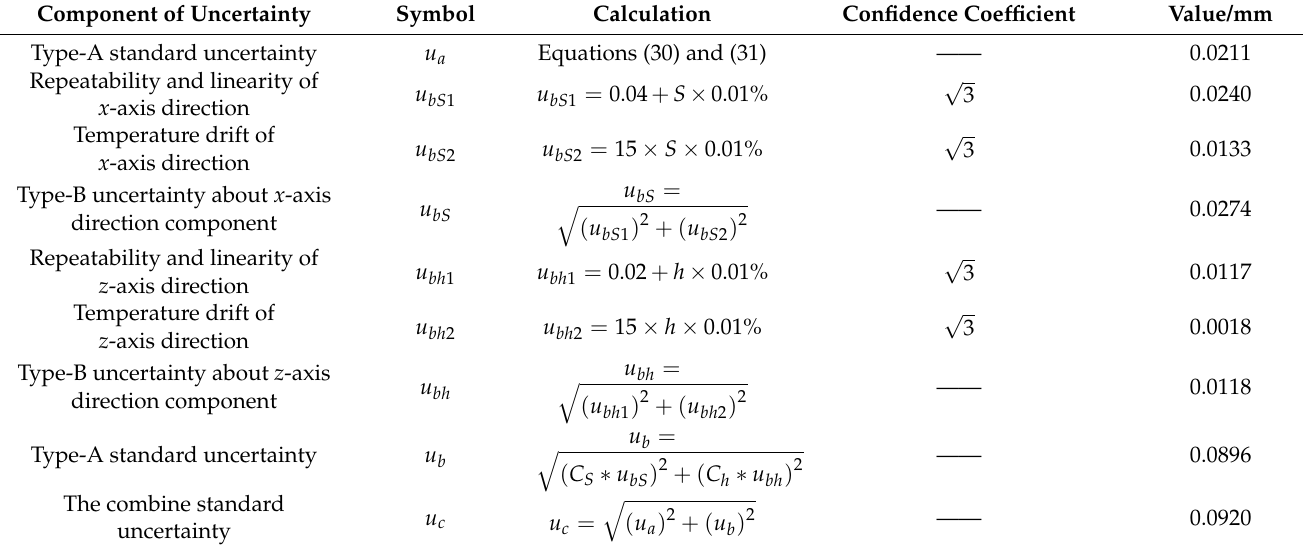
Table 8. The procedure budget about the uncertainty of arc